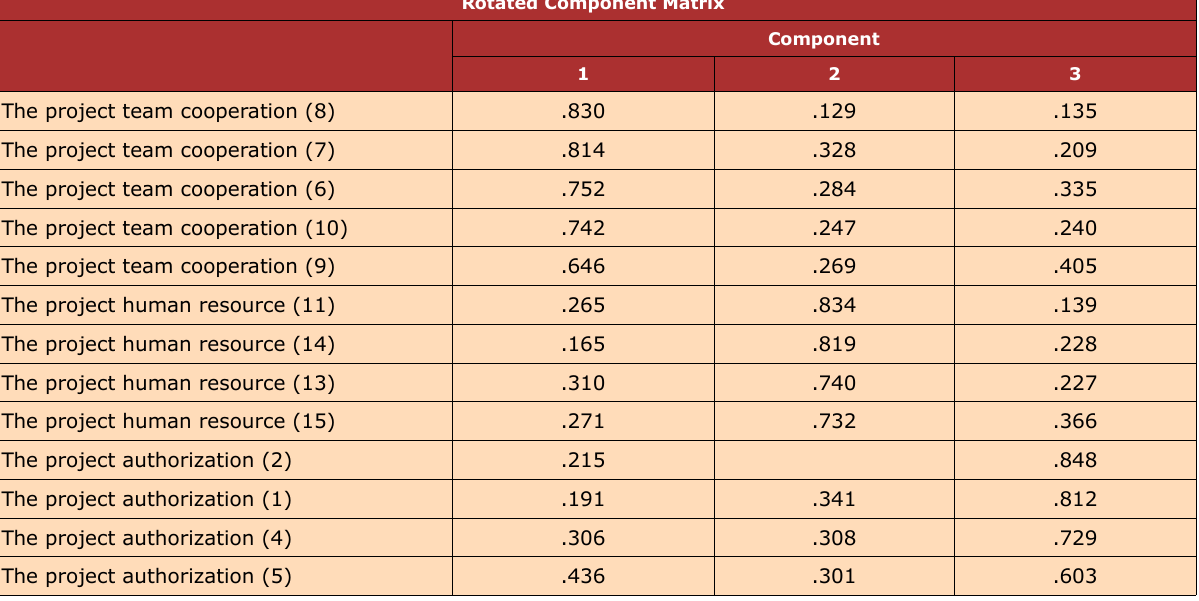
Table 5. Factor analysis of participation